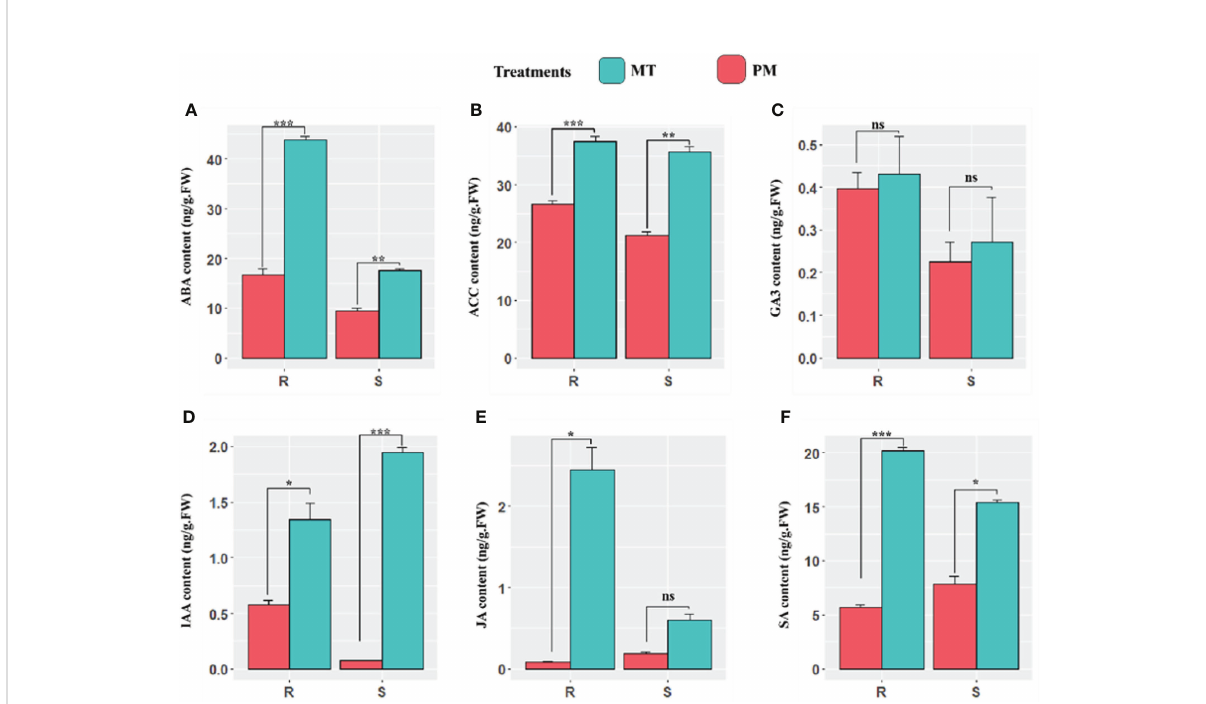
FIGURE 3 The endogenous content of major defense and signaling related phytohormones (A – F) including abscisic acid (ABA), auxin (AUX), ethylene (ACC), methyl jasmonate (MeJA), salicylic acid (SA), over the course of this study (mock-inoculated and PM inoculated after 48h phi) PM infection of susceptible and resistant watermelon lines, over early stages of invasion in leaves. The bars represent the standard error obtained from triplicate samples. *, **, and *** represent signi fi cant differences at P < 0.05, P < 0.01, and P < 0.001 (t-test), respectively. An unpaired t- test (P ≤ 0.05) was applied for the test of signi fi cance in hormone concentration in both contrasting lines. ns, not statistically signi fi